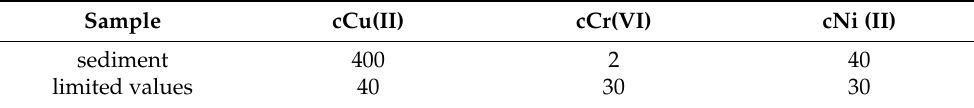
Table 1. Concentration of heavy metals in the raw samples (mg/kg d.m.).